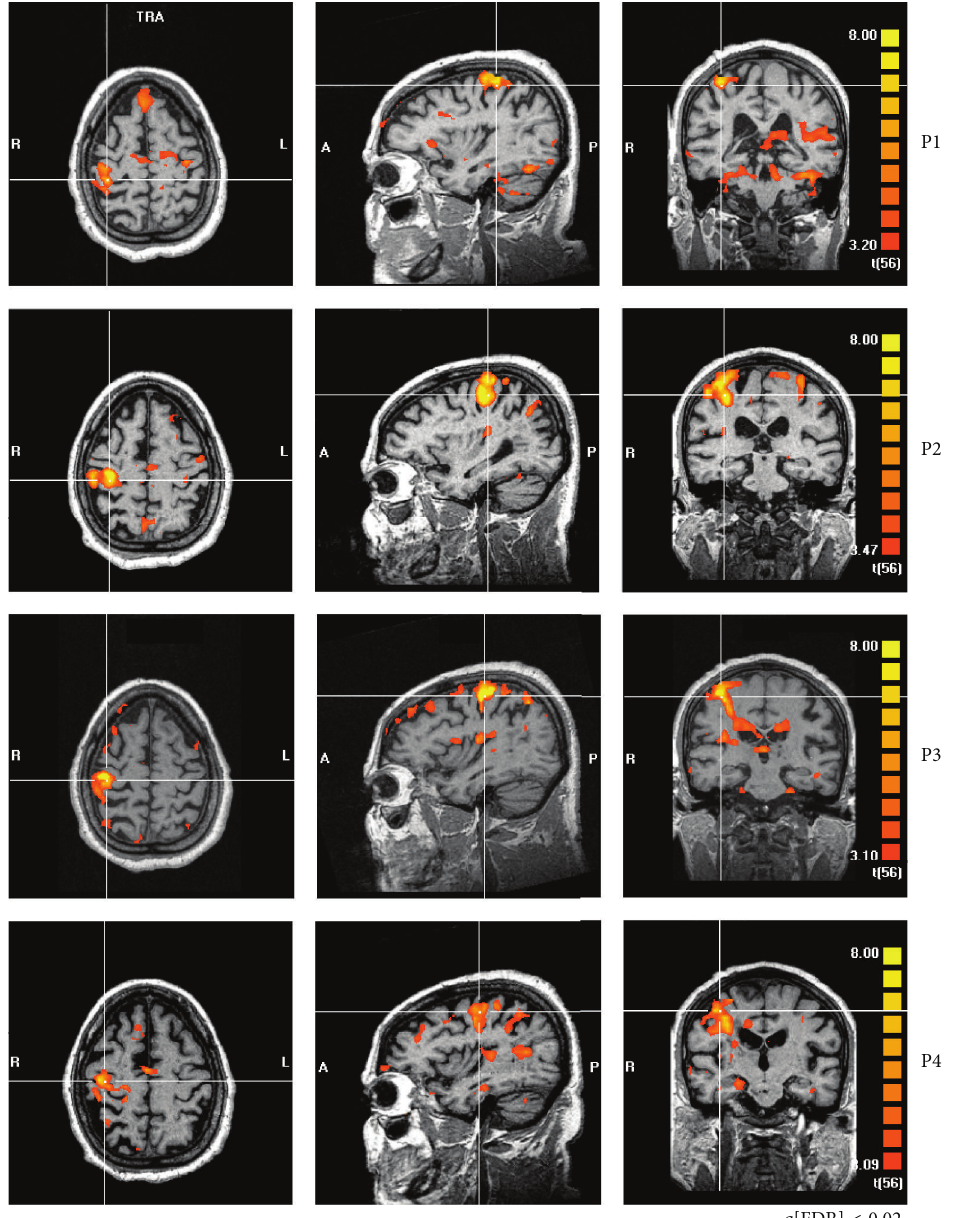
Figure 2: fMRI of a representative patient (#12) in all periods of evaluation (P1, P2, P3, and P4). Cross-lines are centered over M1 of the ipsilesional hemisphere. At P1, bilateral M1 activity, asymmetrical to the ipsilesional hemisphere. The maps are very sparse, particularly at P1. At P2, sparseness is reduced, and the activity is more confined to M1 and SMA. One month without rehabilitation (P3), the patterns become somehow similar to what they were before treatment onset, which is maintained three months after the end of treatment